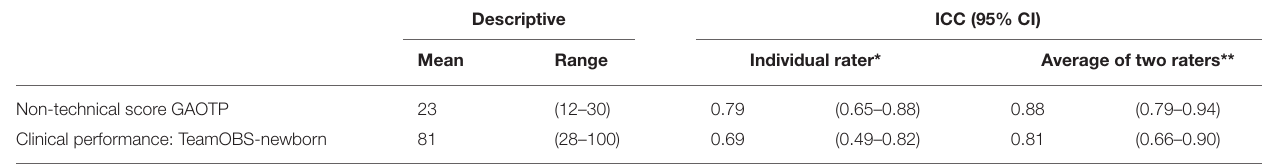
TABLE 1 | Inter-rater agreement for clinical performance and non-technical